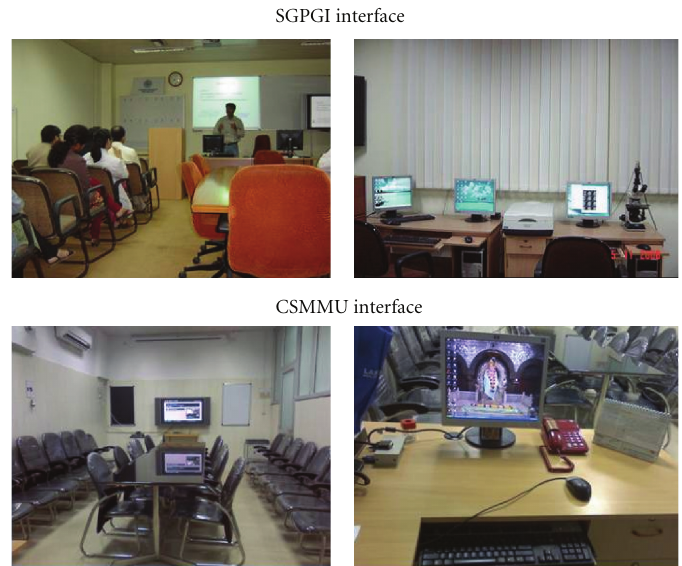
Figure 1: Picture of the telemedicine setup at the primary and remote node.